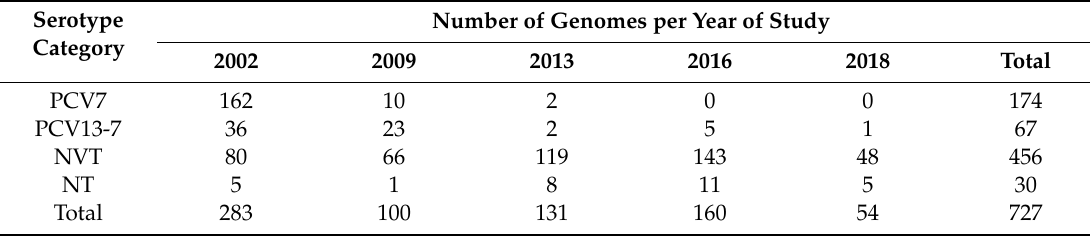
Table 1. Numbers of genomes in each serotype category per study year